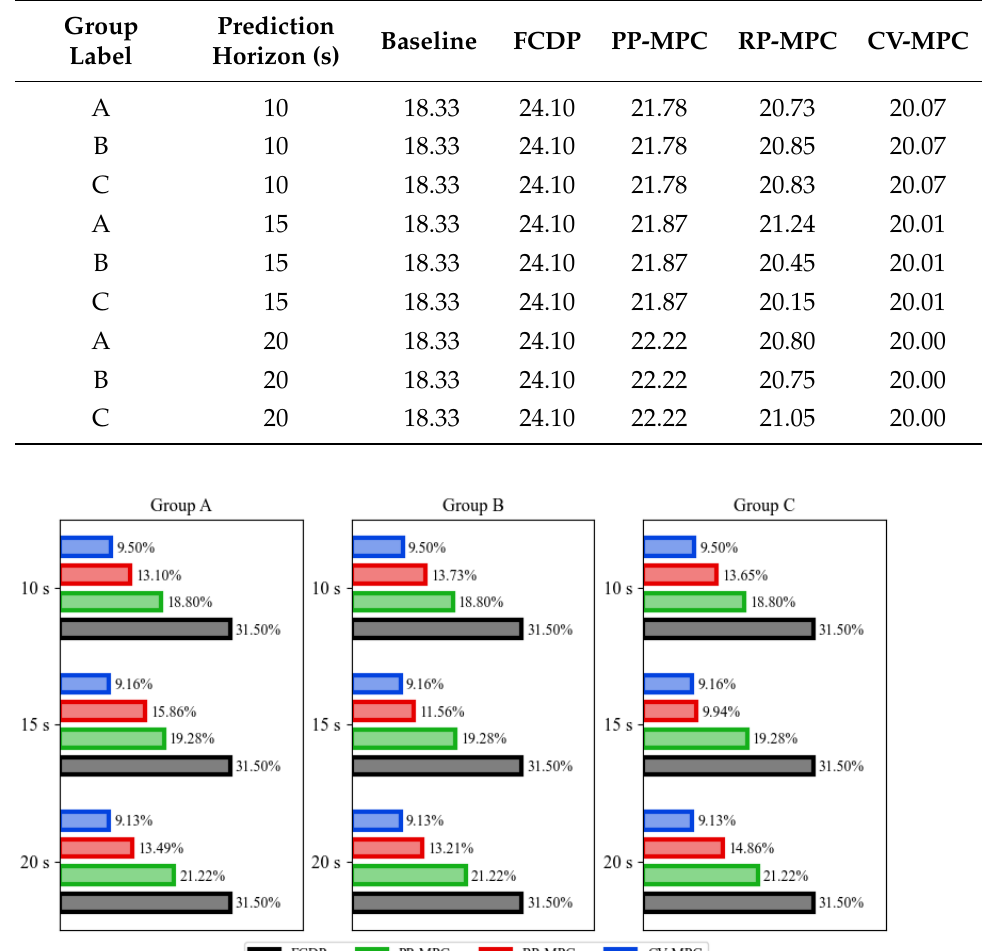
Table 11. FE (km/L) simulation results based on cross-validation study predictions.